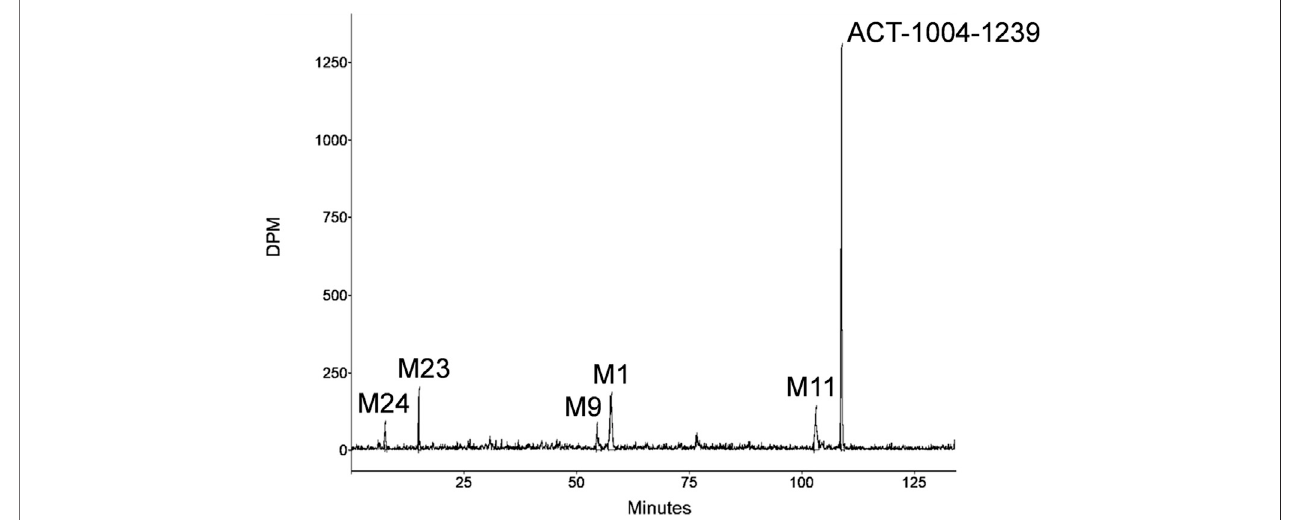
FIGURE 5 | Representative metabolic pro fi le of ACT-1004-1239 in rat urine after intravenous dosing of 14 C-ACT-1004-1239.